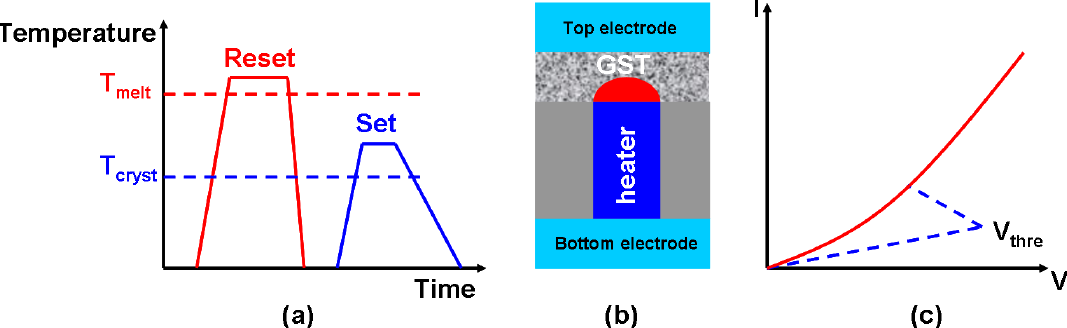
Figure 9. PCRAM and its characteristics: ( a ) its ‘reset’ and ‘set’ operations; ( b ) the architecture of a ‘Lance’ type PCRAM; ( c ) its typical I-V characteristics.